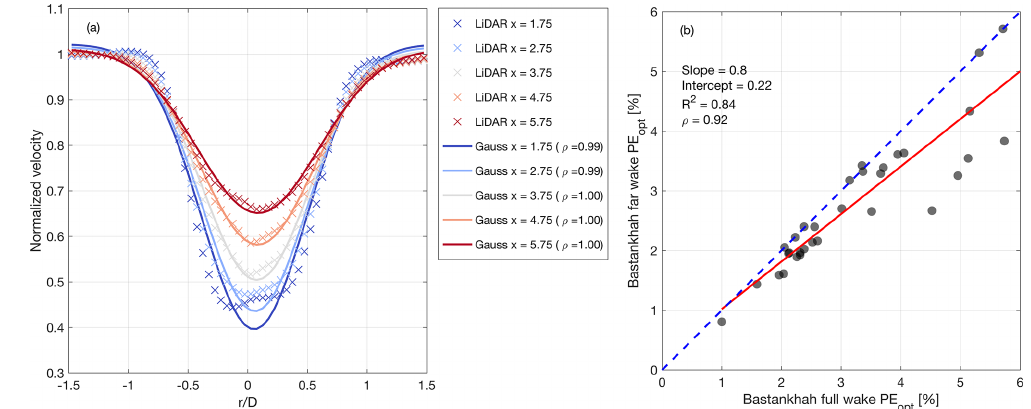
∈ [ 0 . 71, 0.76 ] and TI ∈ [ 7%, 13.5% ] . The cross marker represents Figure 5. (a) Normalized velocity profiles from a lidar cluster with U ∗ hub lidar measurements, solid lines indicate Gaussian fitting, and different colors indicate the downstream location; (b) linear regression between optimized average PE retrieved by using the lidar data for the entire wake or excluding the near-wake region. The solid red line is the linear fit, and the dashed blue line represents a 1 : 1